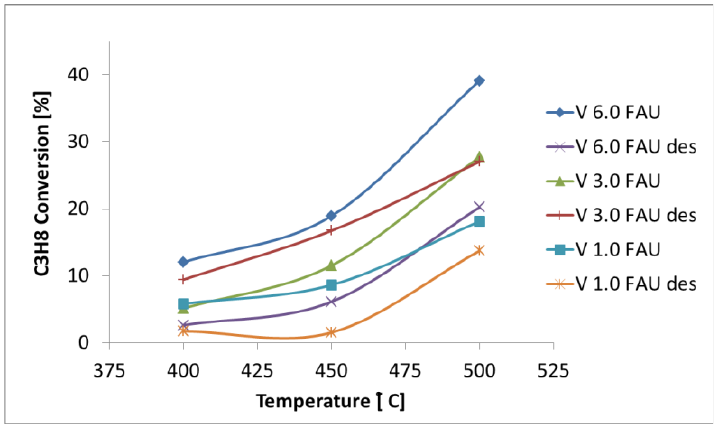
Figure 6. Conversion of propane as a function of the reaction temperature (contact time = 2s).